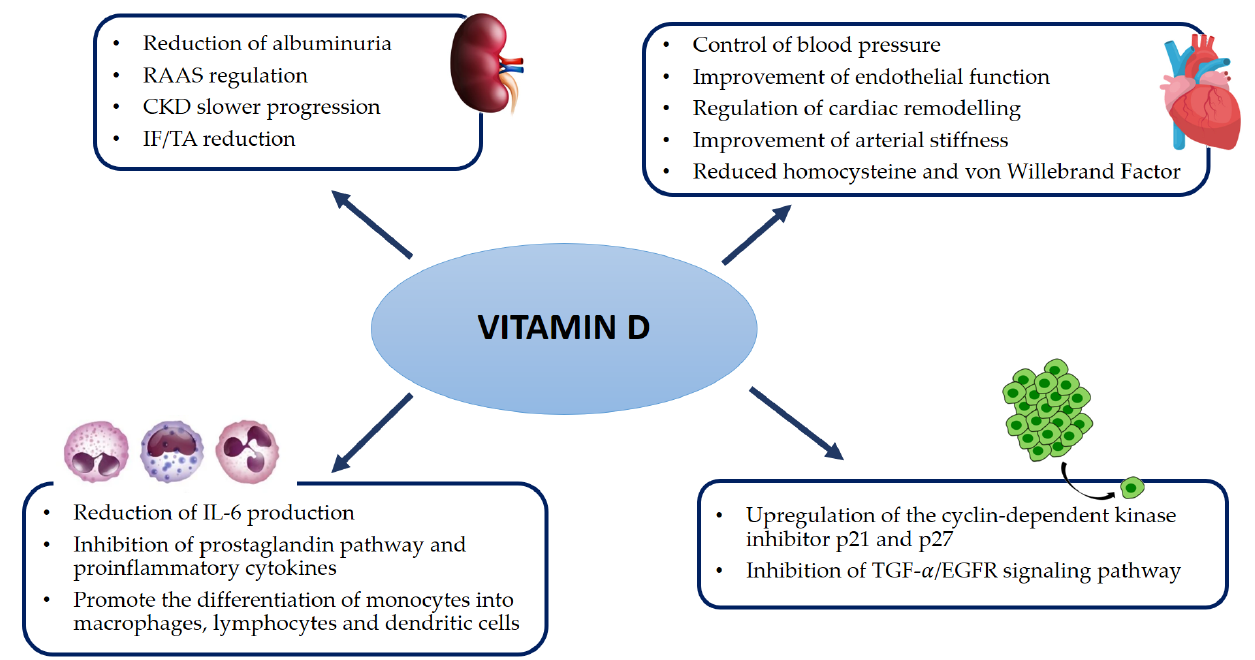
Figure 3. Pleiotropic effect of vitamin D. CKD, chronic kidney disease; EGFR, epidermal growth factor receptor; ESRD, end-stage renal disease; IF/TA, interstitial fibrosis/tubular atrophy; IL-6, interleukin 6; RAAS, renin-angiotensin-aldosterone system; TGF- α, transforming growth factor alpha.